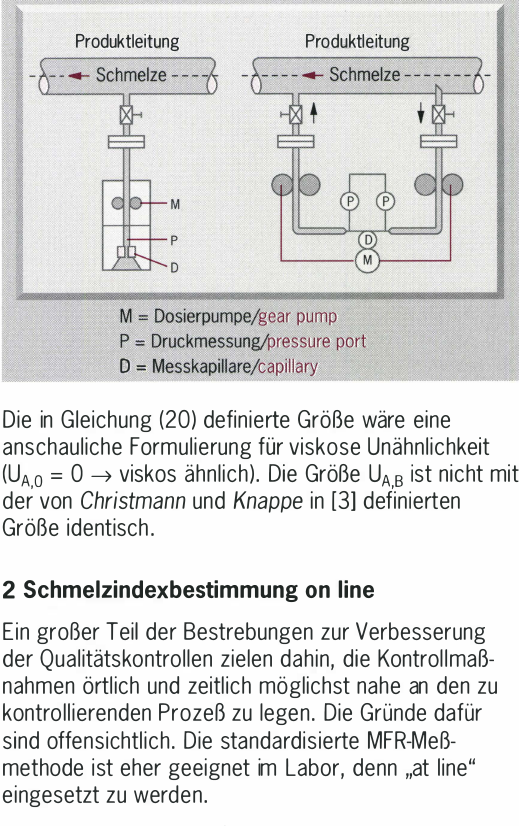
Fig. 7: By-Pass (left) and Side-stream rheometers (right) for on-line measurement (Gottfert)